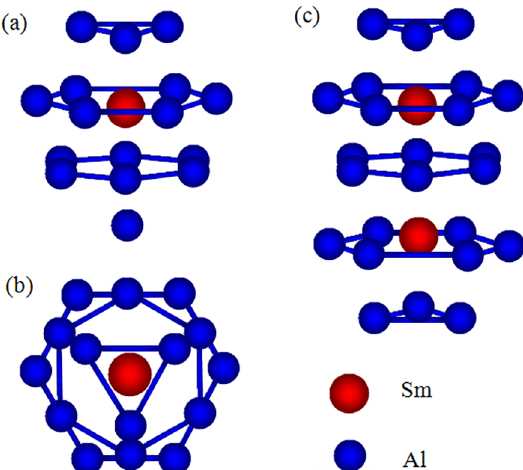
Figure 2. “3661” short-range order surrounding Sm atoms: (a) the side view; (b) the top view; (c) interpenetration of two "3661" clusters.